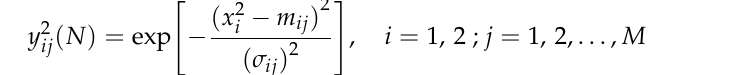
Figure 8. The proposed FNN compensator for MRAC.